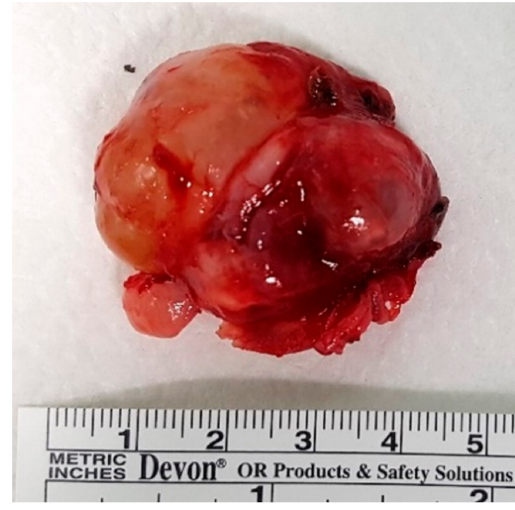
Figure 5. Tumor mass